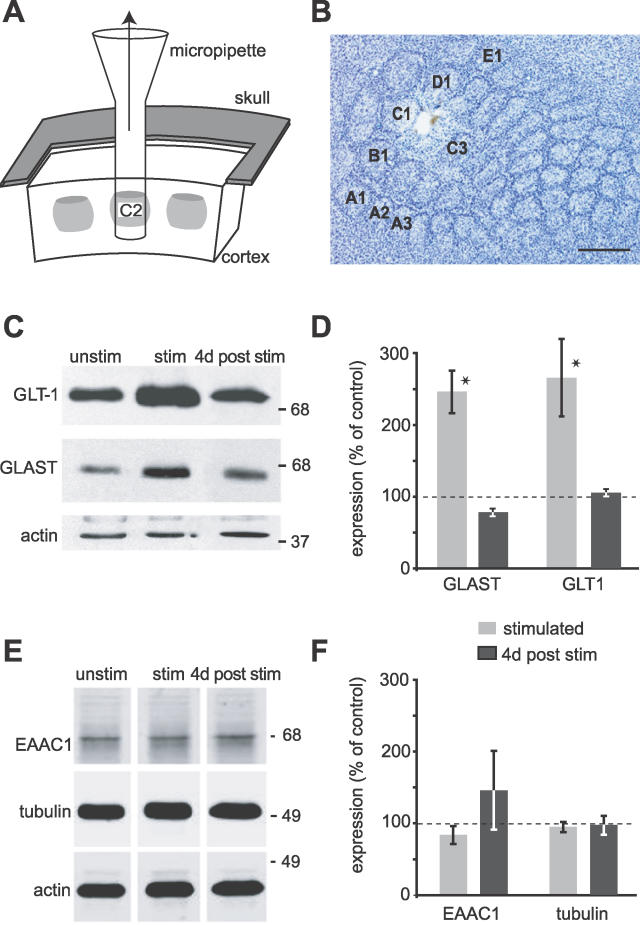
Up-Regulation of GLAST and GLT1 Protein Levels after Whisker Stimulation(A) A single barrel column (C2) was removed by aspiration through a glass micropipette, under sodium pentobarbital anesthesia.(B) Tangential section of the barrel cortex, Nissl stained, shows the location of the excised barrel column. A clear hole can be seen in the section in the region of barrel C2, with the neighboring barrels intact.(C) Representative immunoblot microassay of C2 columns dissected immediately after 24 h of C2 whisker stimulation (stim), 4 d after stimulation (4 d post stim), and from unstimulated mice (unstim). Blot was probed for GLAST, GLT1, and actin, and indicates an increase in GLAST and GLT1 levels after 24 h of whisker stimulation, but not 4 d later.(D) These changes were quantified using densitometry with the values being normalized against the actin levels. Results were expressed as percentages of levels in unstimulated mice (100%) and statistically analyzed with a Tukey studentized range test, p < 0.01; error bars indicate SD. Scale bar in (B) indicates 0.5 mm.(E) Representative immunoblots from animals treated as in (C), and analyzed for protein levels of EAAC1, tubulin, and actin.(F) Quantification of the immunoblot signals revealed no significant alteration in EAAC1 levels in stimulated animals. EAAC1 and tubulin values were normalized on actin levels, and expressed as % of level in control animals. Note that the relative level of tubulin was unchanged by the stimulation. Error bars indicate SD.